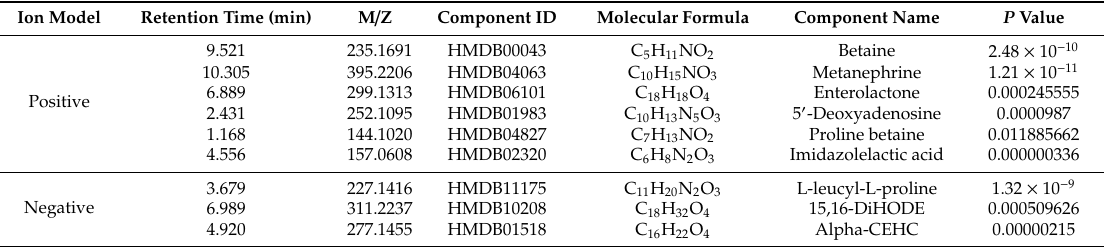
Table 1. Preliminary identification results of endogenous metabolites in plasma of rats in each